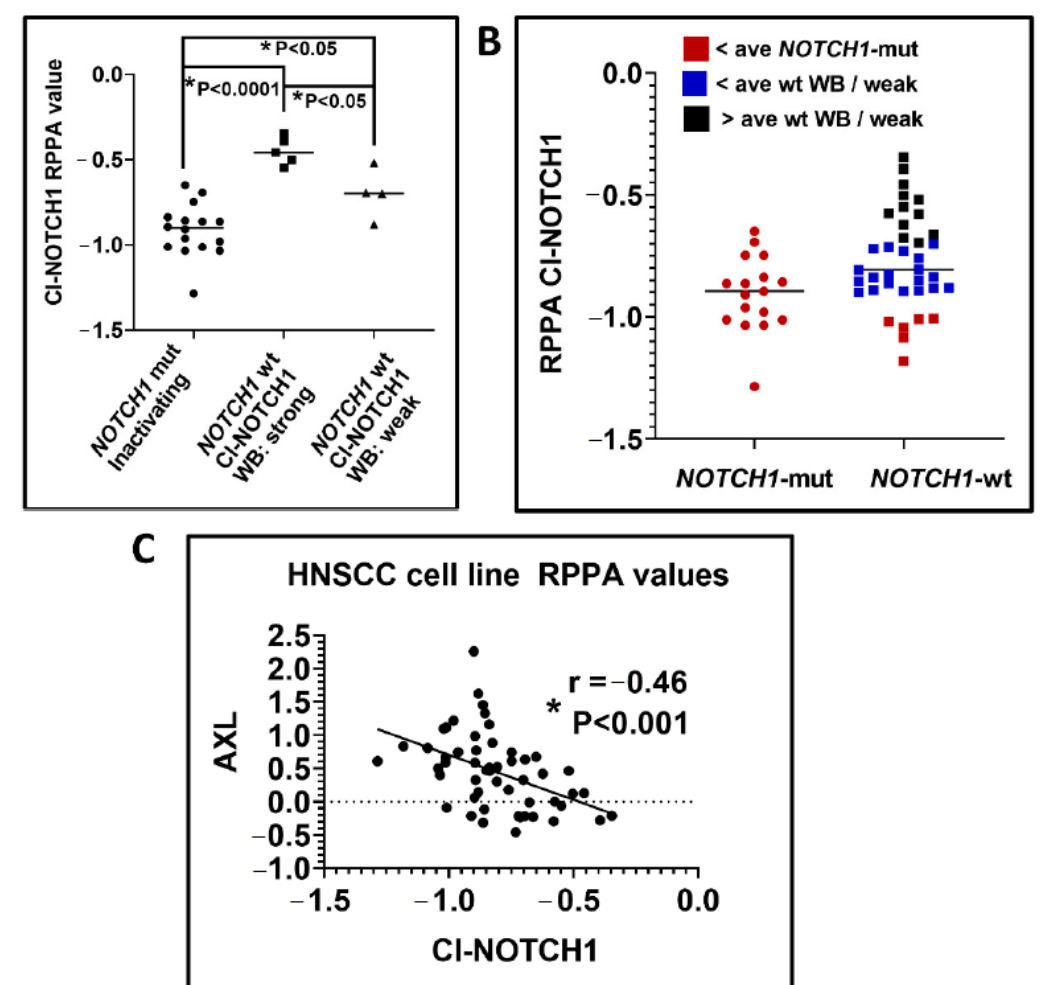
Figure 6. Levels of activated NOTCH1 by reverse phase protein arrays (RPPA) correlate with NOTCH1 mutational status, immunoblot data, and AXL expression. ( A ) RPPA protein expression of activated cleaved Cl-NOTCH1 (ICN1) is significantly lower in HNSCC cell lines with inactivating NOTCH1 mutations compared to NOTCH1 -wt cell lines. Cell lines with strongest Cl-NOTCH1 signal on Western blots (squares) had higher levels of Cl-NOTCH1 by RPPA as well. Significance was determined by a one-way ANOVA followed by Tukey’s multiple comparison test. ( B ) The distribution of Cl-NOTCH1 levels measured by RPPA among NOTCH1 -wt HNSCC cell lines compared to expression in NOTCH1 -mut tumors. NOTCH1 -wt cell lines (red square symbols) with Cl-NOTCH1 RPPA values below the average observed for NOTCH1 mutants or below the average value for NOTCH1 -wt cell lines with only weak expression on Western blot (blue square symbols) identify cell lines lacking strong endogenous NOTCH1 pathway activation. Roughly one third of NOTCH1 -wt cell lines (black square symbols) analyzed had RPPA values in a range that matched cells with strong pathway activation confirmed by immunoblots. ( C ) Strong anti-correlation between Cl-NOTCH1 expression and total AXL protein as measured by RPPA in HNSCC cell lines. The significance of the correlation coe ffi cient was determined with a t -test. WB, Western blot; ave, Average; mut, Mutant; wt, Wild